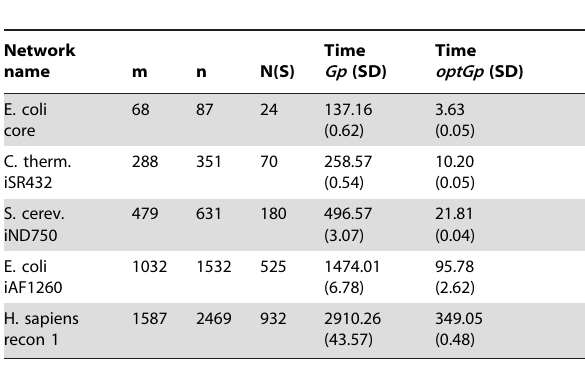
Table 2. Runtimes for the networks